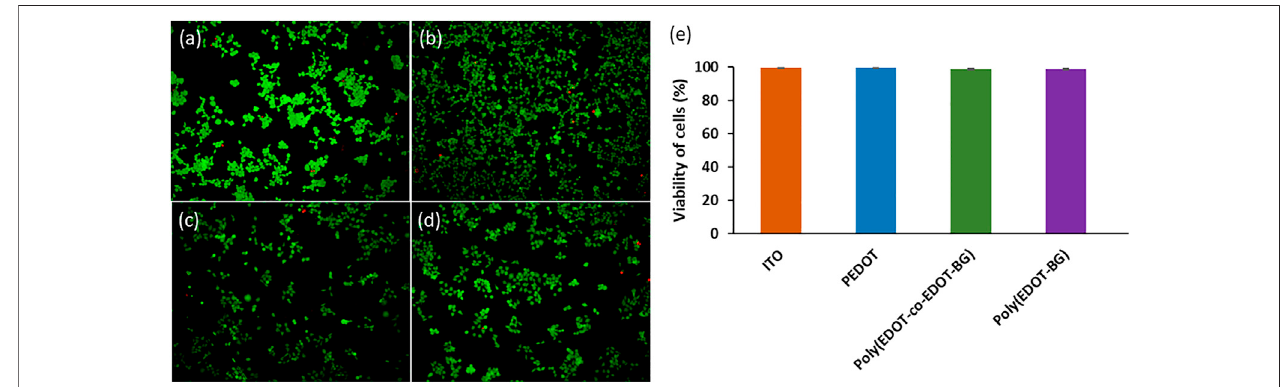
FIGURE 6 | Bactericidal ef fi ciency of the polymers on E. coli . (A) Fluorescence microscopy images of live (green) and dead (red) bacteria cells cultured on different substrates (incubated for 2 h at 37 ° C) and (B) graph showing the bactericidal ef fi ciency (%).